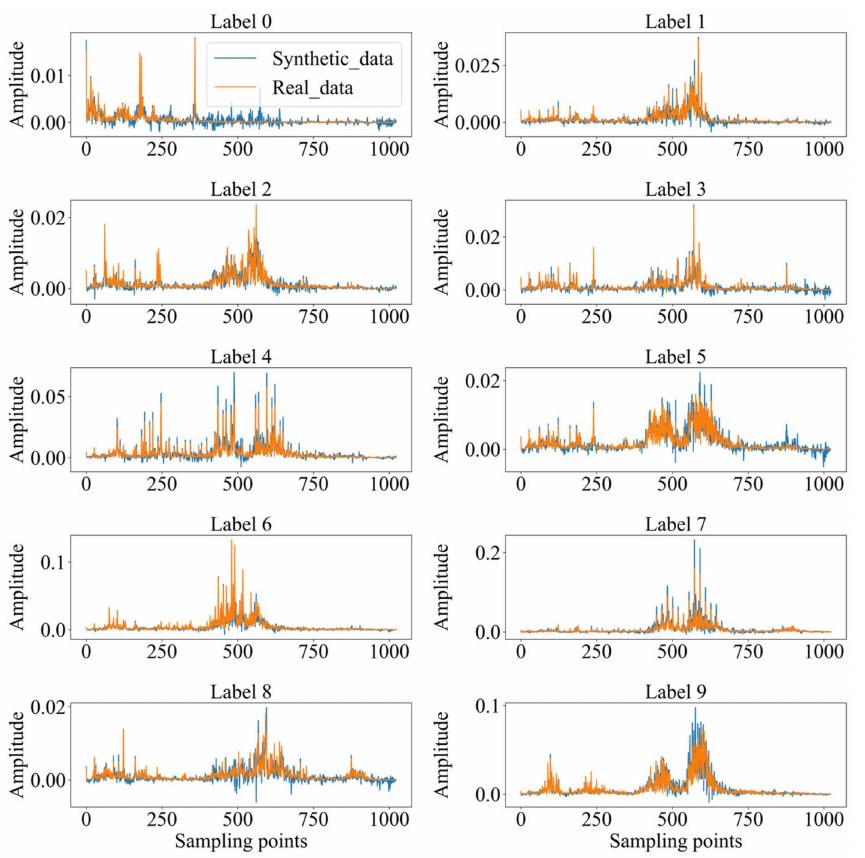
Figure 9. Comparison of the frequency spectrum of the real and synthetic samples data of the bearing dataset.